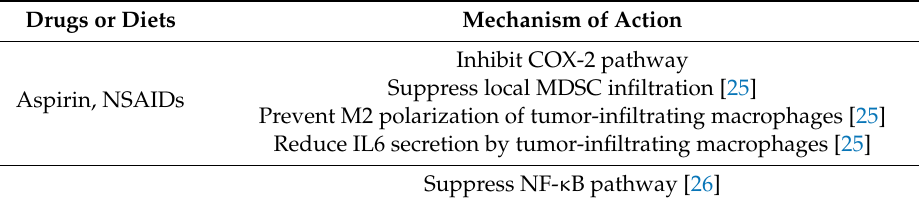
Table 1. Potential drugs and diets for preventing prostate cancer progression by controlling the